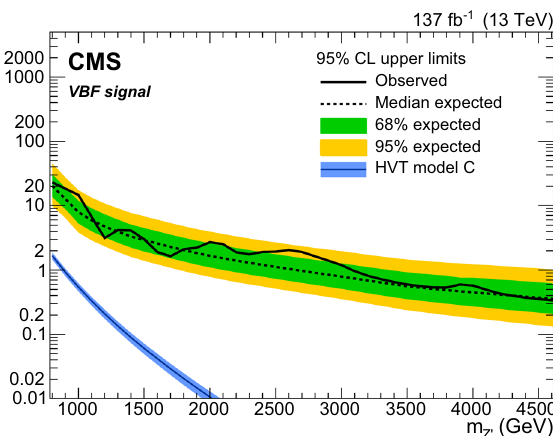
and FWF (Austria); FNRS and FWO (Belgium); CNPq, CAPES, FAPERJ, FAPERGS, and FAPESP (Brazil); MES (Bulgaria); CERN; CAS, MoST, and NSFC (China); COLCIENCIAS (Colombia); MSES and CSF (Croatia); RIF (Cyprus); SENESCYT (Ecuador); MoER, ERC PUT and ERDF (Estonia); Academy of Finland, MEC, and HIP (Fin- land); CEA and CNRS/IN2P3 (France); BMBF, DFG, and HGF (Ger- many);GSRT(Greece);NKFIA(Hungary);DAEandDST(India);IPM (Iran);SFI(Ireland);INFN(Italy);MSIPandNRF(RepublicofKorea); MES (Latvia); LAS (Lithuania); MOE and UM (Malaysia); BUAP, CINVESTAV,CONACYT,LNS,SEP,andUASLP-FAI(Mexico);MOS (Montenegro); MBIE (New Zealand); PAEC (Pakistan); MSHE and NSC (Poland); FCT (Portugal); JINR (Dubna); MON, RosAtom, RAS, RFBR, and NRC KI (Russia); MESTD (Serbia); SEIDI, CPAN, PCTI, and FEDER (Spain); MOSTR (Sri Lanka); Swiss Funding